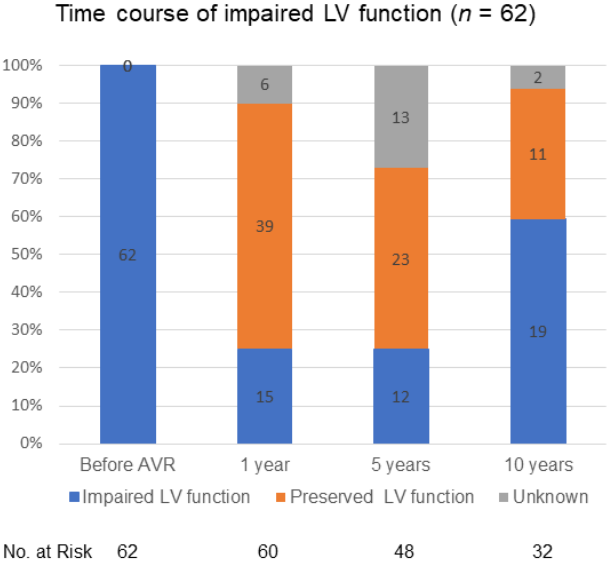
Figure 2. Time course of impaired LV function during 10 years of follow-up. LV: left ventricular. AVR: aortic valve replacement.